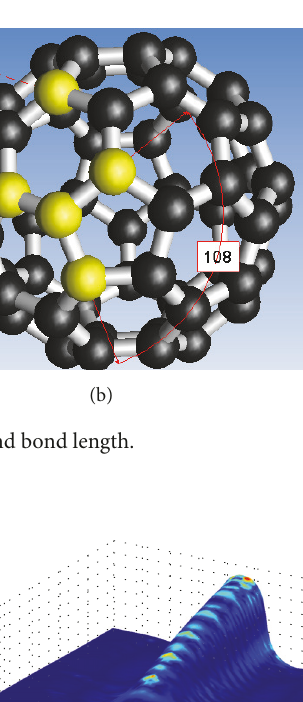
Figure 27: Physical meaning based editing for nanotube.